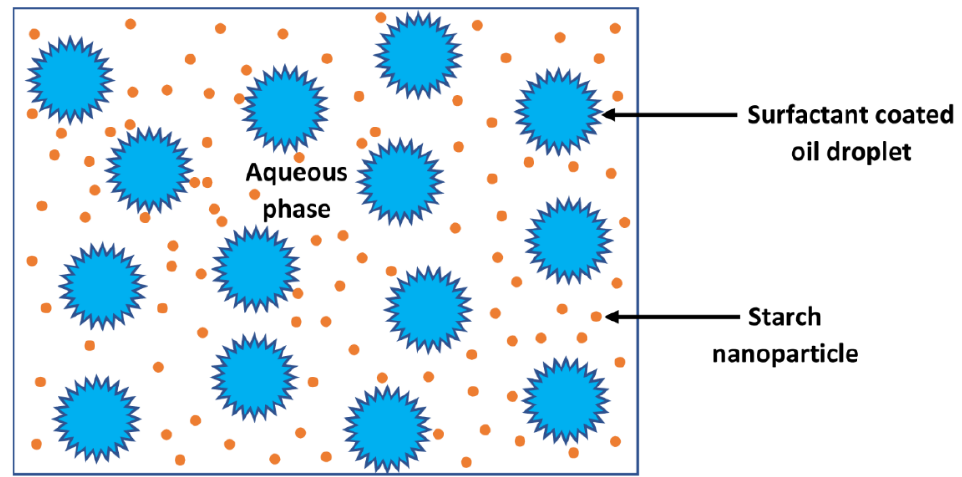
Figure 1. Schematic of the type of emulsions investigated in the present